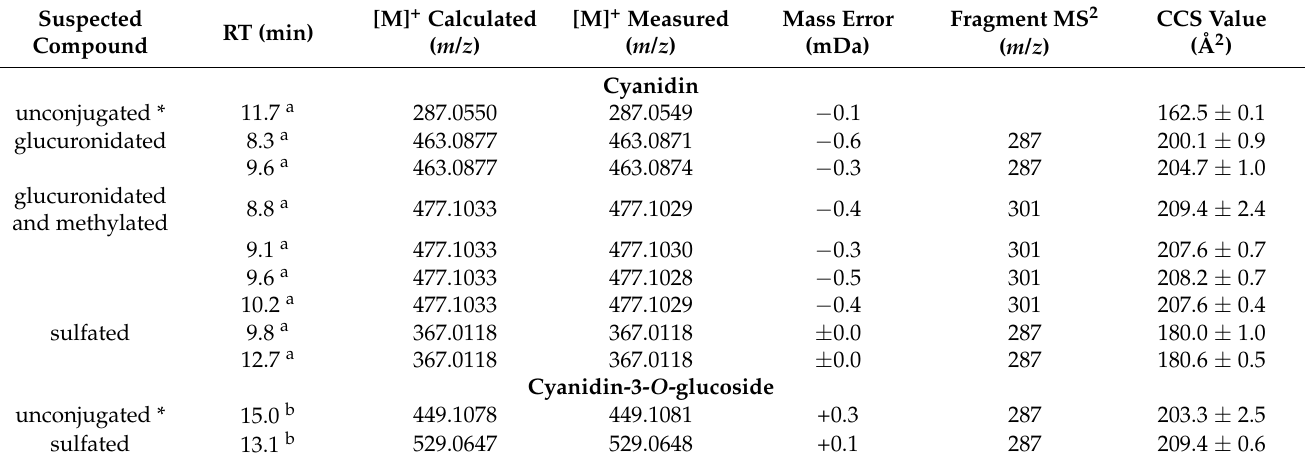
Table 3. LC-DAD-ESI-IMS-QTOF results of the analysis of urine collected for 24 h after the consumption of blackberry juice, either gradient a or